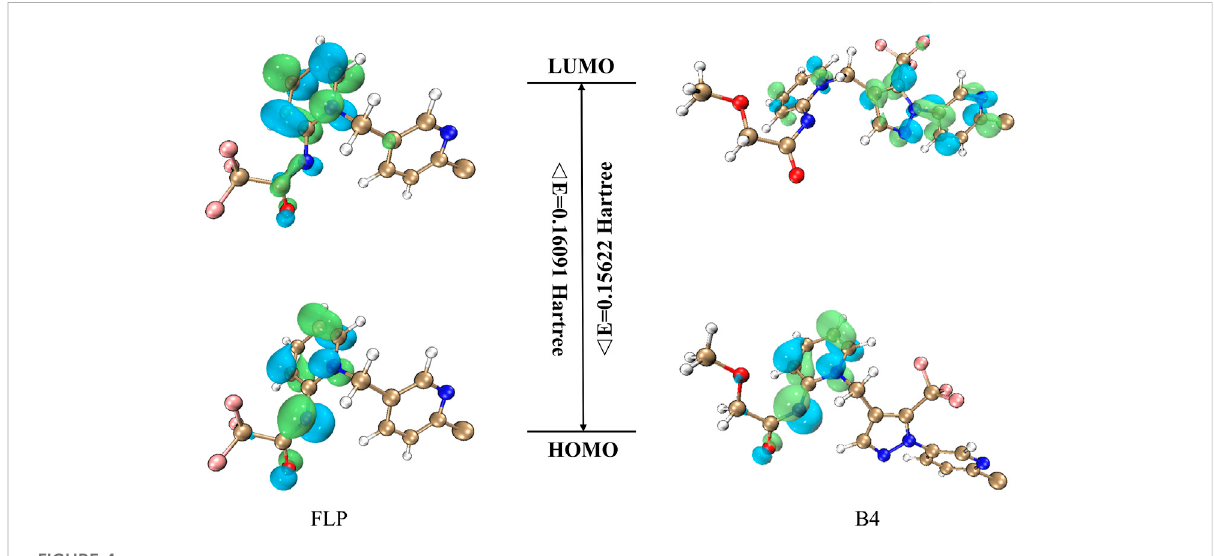
FIGURE 4 Frontier molecular orbitals of FLP ( fl upyrimin) and B4 .